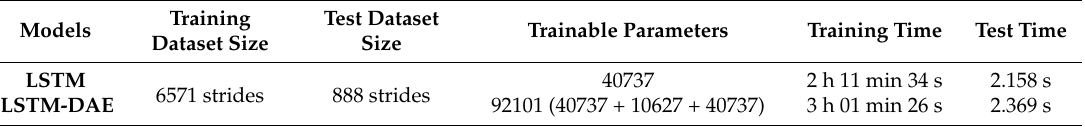
Table 4. Comparison of time